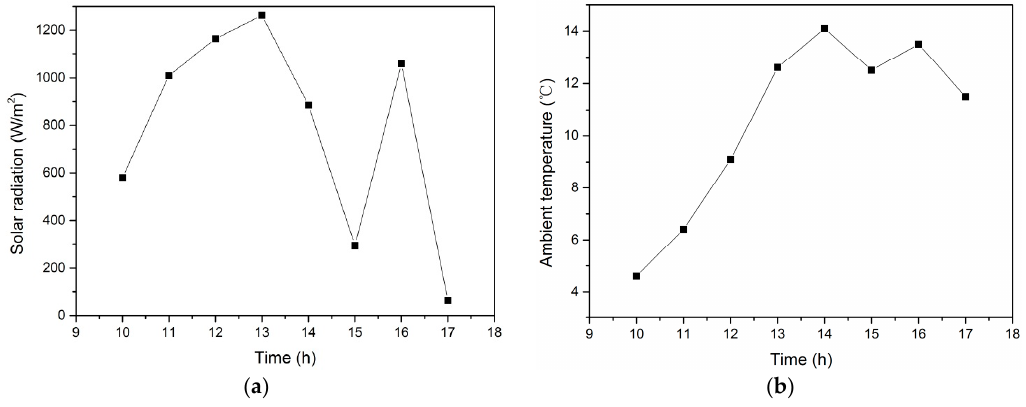
Figure 5. ( a ) Solar radiation and ( b ) ambient temperature.